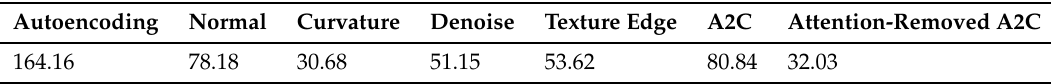
Table 3. Standard deviation of the reward distribution. A2C, attention-augmented contrastive learning method.